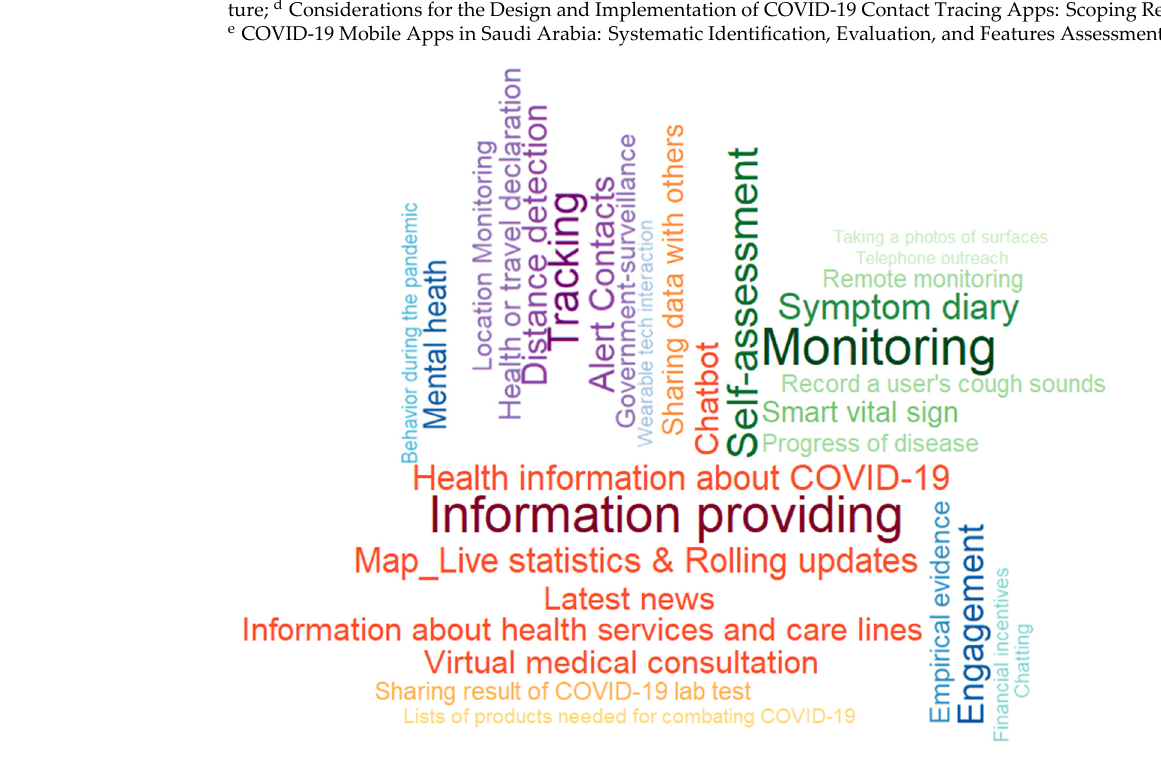
Figure A1. Word Cloud for content frequency.